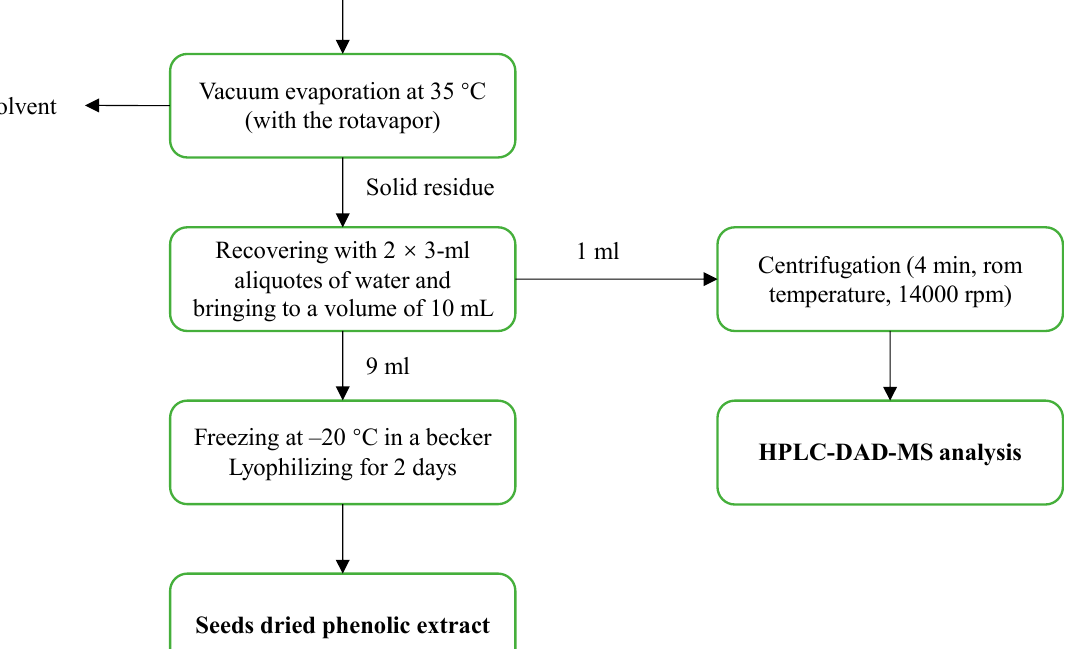
Figure 2. Dried phenolic extract from the seeds of the Moraiolo cultivar at the fourth sampling point. 2.3. Characterization of the Phenolic Profile of Olive Seeds over the Course of Ripening Table 2 reports the evolution over the course of ripening of the content of the molecules identified in olive seeds of the three cultivars, Frantoio (Table 2A), Moraiolo (2B) and Leccino (2C), based on UV and mass spectra analyses and literature data. An example of a chromatogram of the phenolic profile of seeds of the Moraiolo cultivar is given in Figure 3. Overall, 19 molecules were tentatively identified, 16 of which bore at least one phenolic moiety in their chemical structure. The remaining three molecules (i.e.,